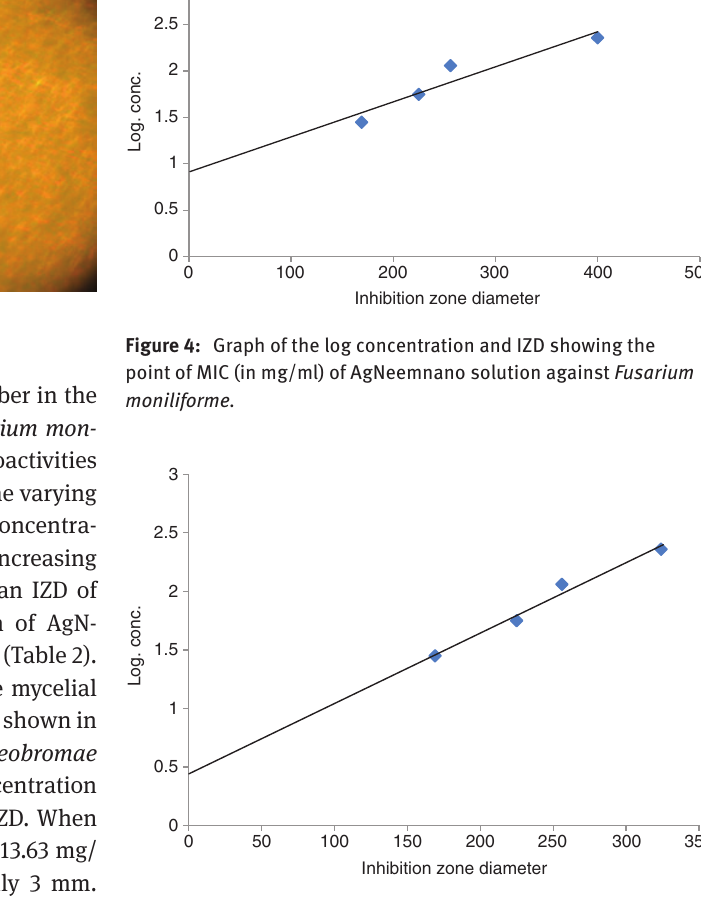
Figure 5: Graph of the log concentration and IZD showing the point of MIC (in mg/ml) of AgNeemnano solution against Lasiodiplodia theobromae